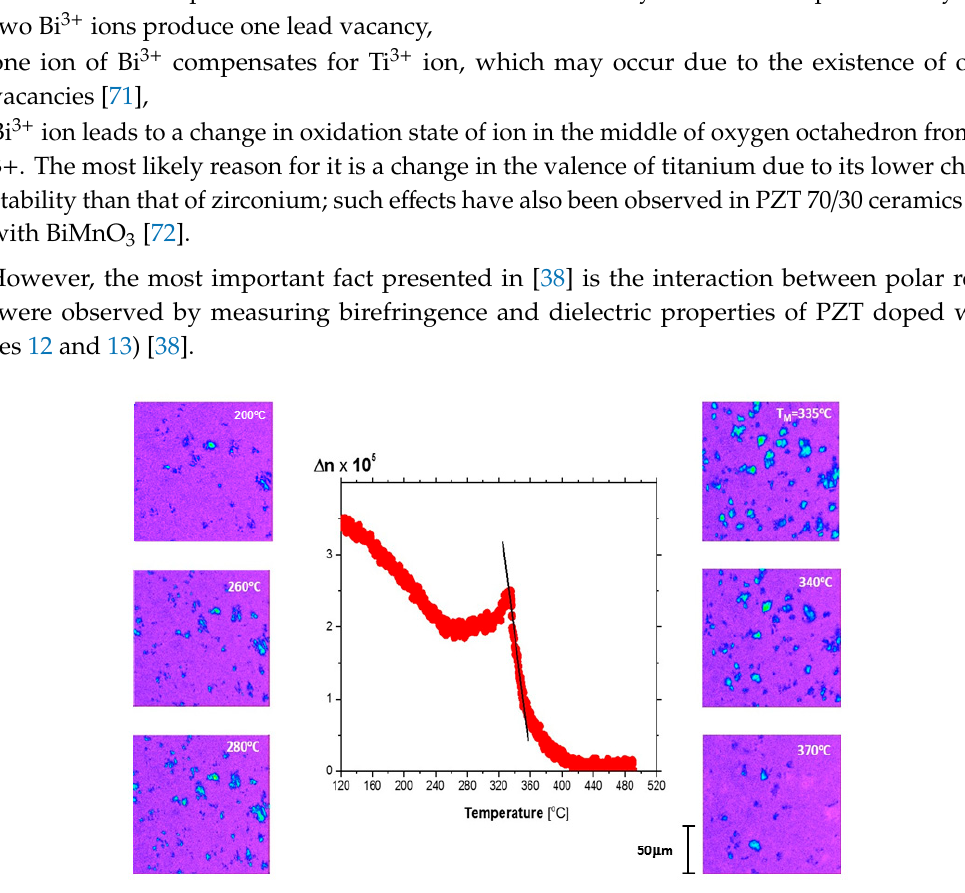
Figure 12. (middle part) Temperature changes of birefringence (average values), after subtracting the background generated by the set-up, for areas of 500 × 450 μ m 2 of ceramics PZT70/30 doped with 0.2 mol% Bi 2 O 3 . This area contains over 200 grains. On the left and right side there are birefringence maps for selected temperatures, showing the evolution of polar regions in terms of size. The size of birefringent regions (blue bright spots) is interpreted as size of polar regions. Linear changes of Δ n as function of temperature were observed above the T m temperature (maximum of permittivity) [38].